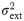
Performance for variations of the input variance.Time series of population spike rate and mean adaptation current from the different models in response to varying σext2 for large mean input and rapid variations, μext = 4 mV/ms, τouσ2=5ms (A) and for small mean input and moderately fast variations, μext = 1.5 mV/ms, τouσ2=50ms (B). The values for the remaining input parameters were σ¯ext2=9mV2/ms, ϑσ2 = 2 mV2/ms. For the aEIF population 〈w〉± standard deviation are visualized (red shaded areas). Note that the mean adaptation time series of all models as well as the spike rates of the cascade based models are on top of each other. The indicated Pearson correlation coefficients (with dashed input-output correlation) and root mean square distances were calculated from simulated spike rate time series of 60 s duration from which the first second was excluded, as the initial conditions of the models were not matched. In A the correlation ρ (but not the distance dRMS) between the spike rates of the model spec1 and the aEIF population) is strongly decreased due to a small time lag between the two time series which is difficult to see in the figure.